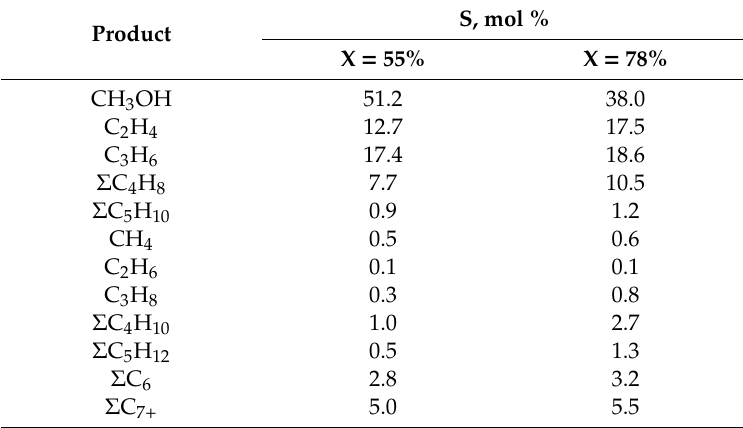
Table 4. Product distribution for HZSM-5 / Al 2 O 3